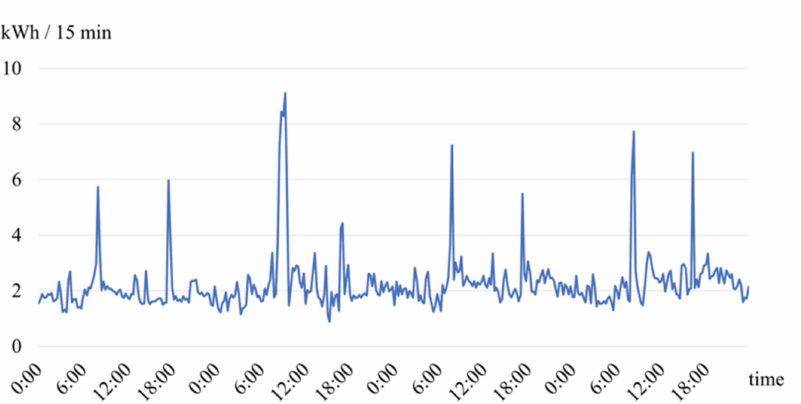
Figure 2. Daily load curves of electricity consumption in the dairy barn with milking robot on four consecutive days. Source: survey dairy farm 2020.